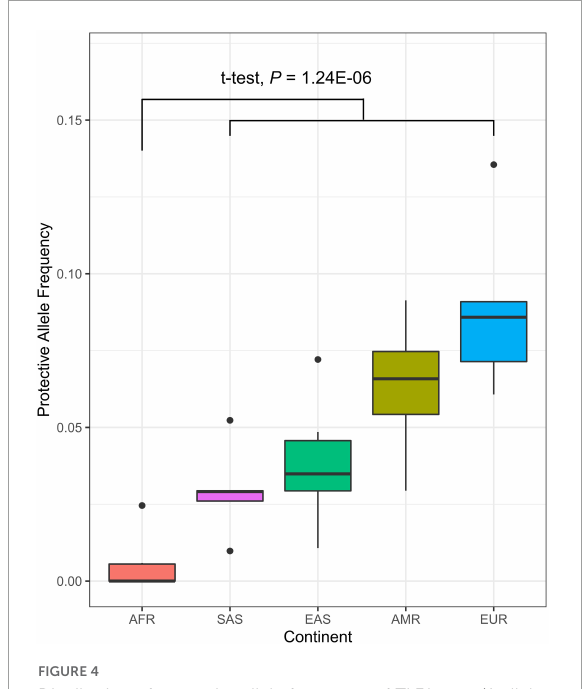
FIGURE4 Distribution of protective allele frequency of TLE1 gene (A allele; chr9:84302707) in diverse populations. Each represents the protective allele frequency of the corresponding country. The t -test describes the allele frequency differentiation between the African continent (AFR) and the rest (SAS, South Asia; EAS, East Asia; AMR, America; EUR,